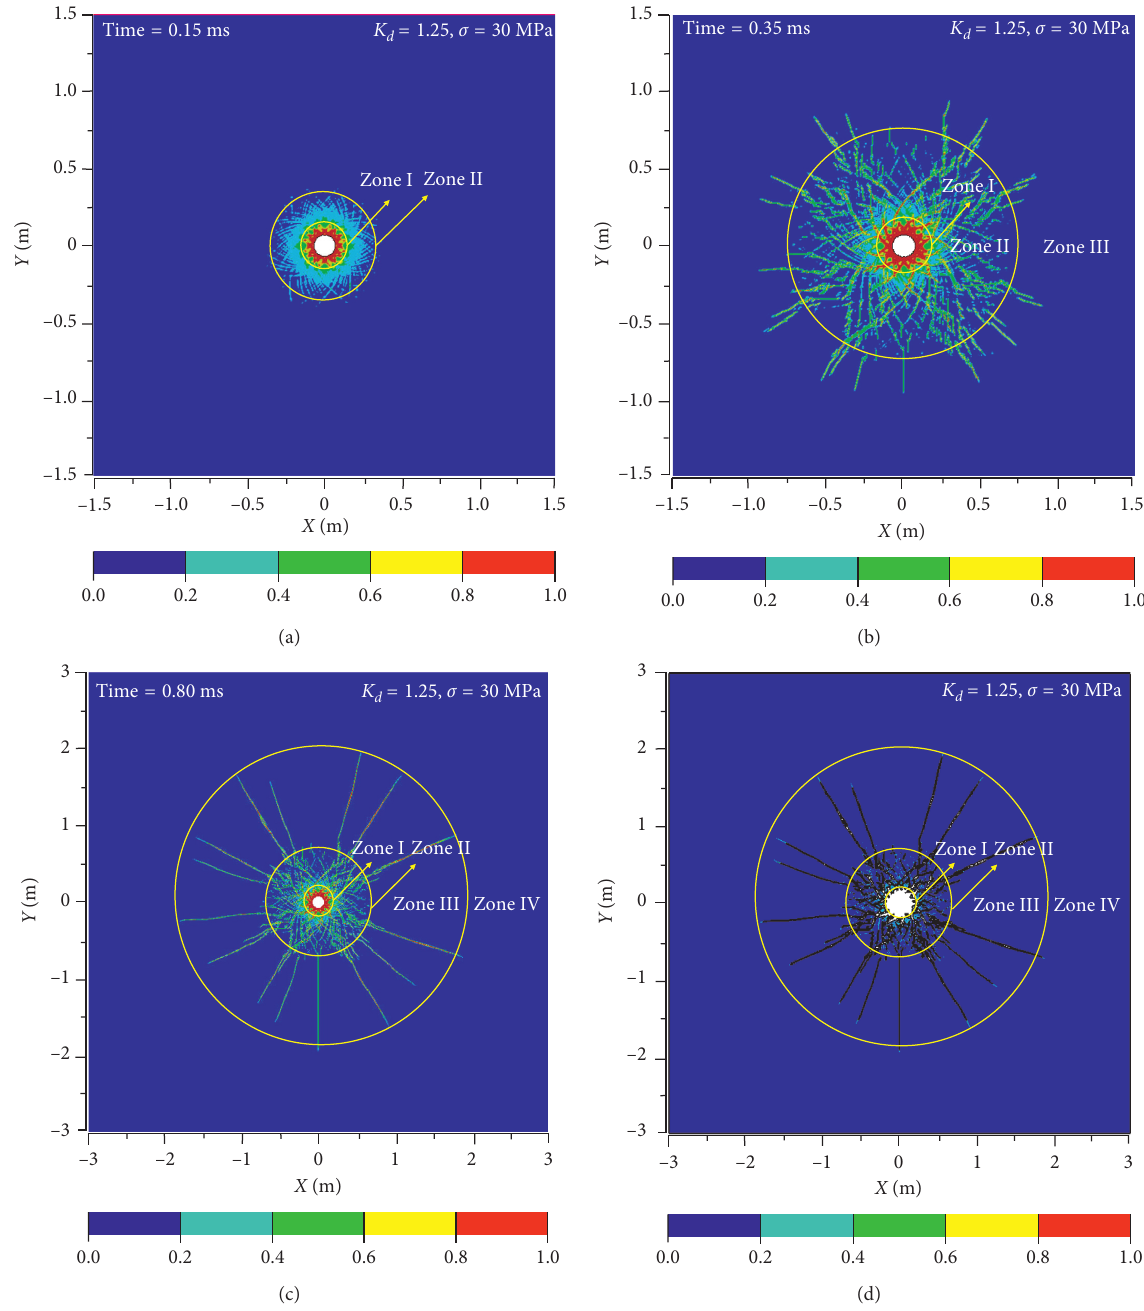
Figure 7: Consecutive stages of the blast-induced cracking process under high in situ stress ( K crushed zone, nonlinear fracture zone, and radial crack propagation zone; (c) extension of the crushed zone, nonlinear fracture zone, and radial crack propagation zone; (d) crack pattern by blanking damaged